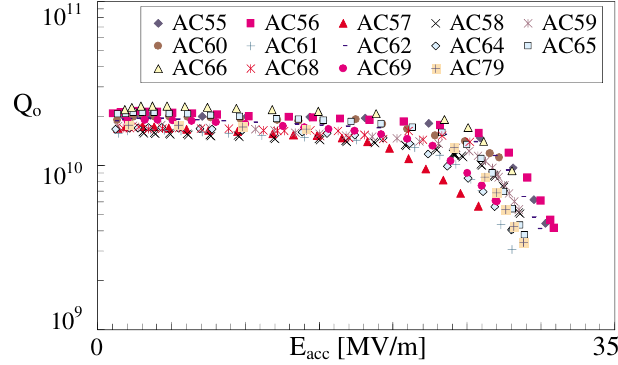
FIG. 2. (Color) Q vs E of 14 TTF cavities from the third o acc production at